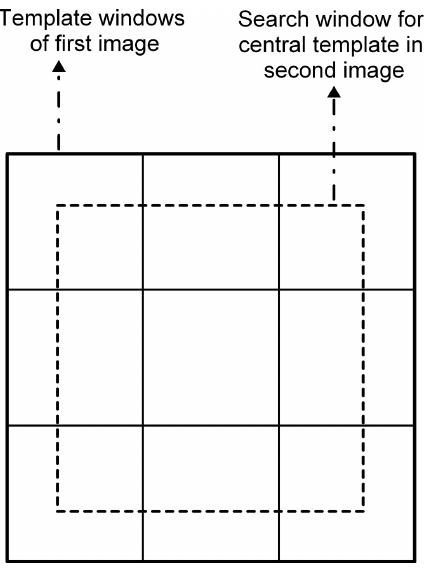
(b) Vector indicating where in the second image the centre of the window (dotted line) closest to the original template (solid line) lies.